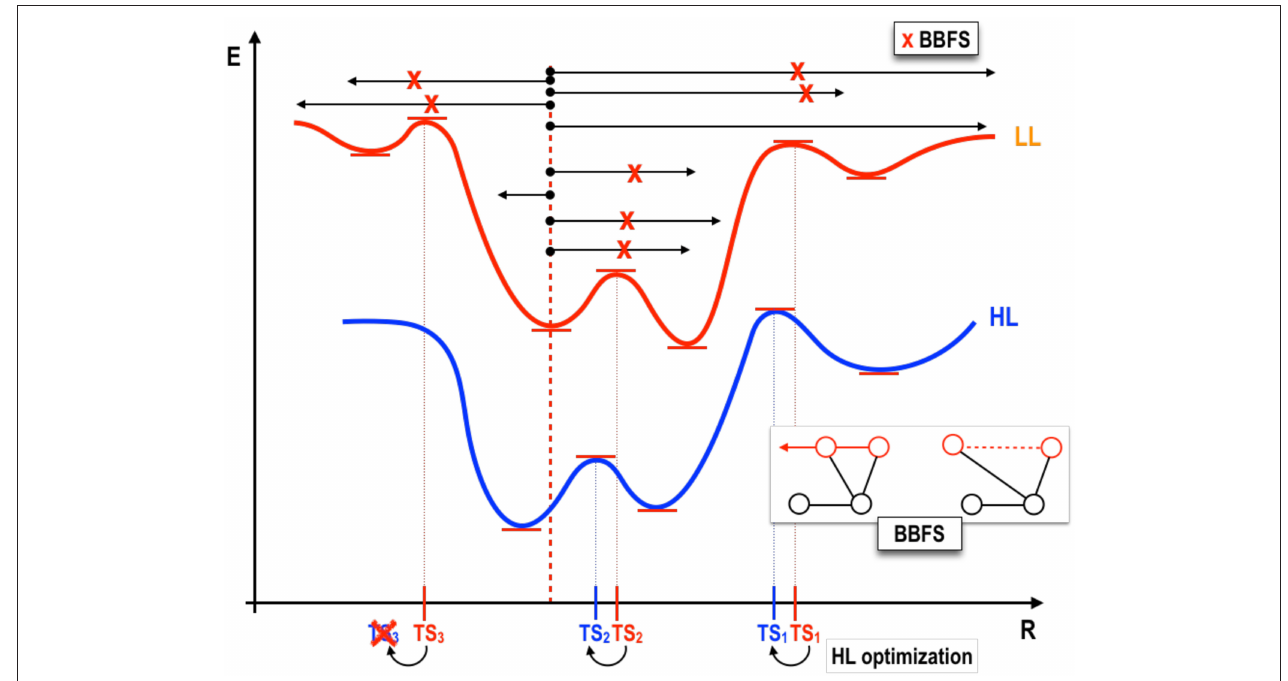
FIGURE 2 | One-dimensional representation of the TSSCDS procedure. A low level (LL) PES (upper energy curve, in red) is sampled starting from a given minimum (geometry indicated by a red dotted line). Classical random trajectories (black arrows) in combination with a graph theory based method (Bond Breaking/Formation Search, BBFS Martínez-Núñez, 2015a,b) lead to the determination of TS candidate structures (marked as x in red bold font), compatible with the total energy of the trajectories, from which LL optimizations are started. Subsequent optimization at the desired high-level (HL) are performed using the LL TS as guess